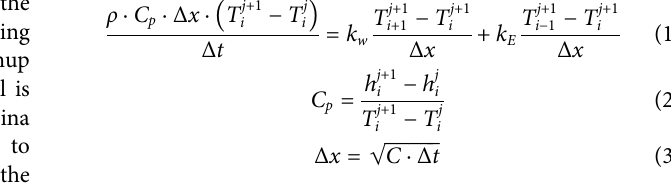
Frontiers in Energy Research |